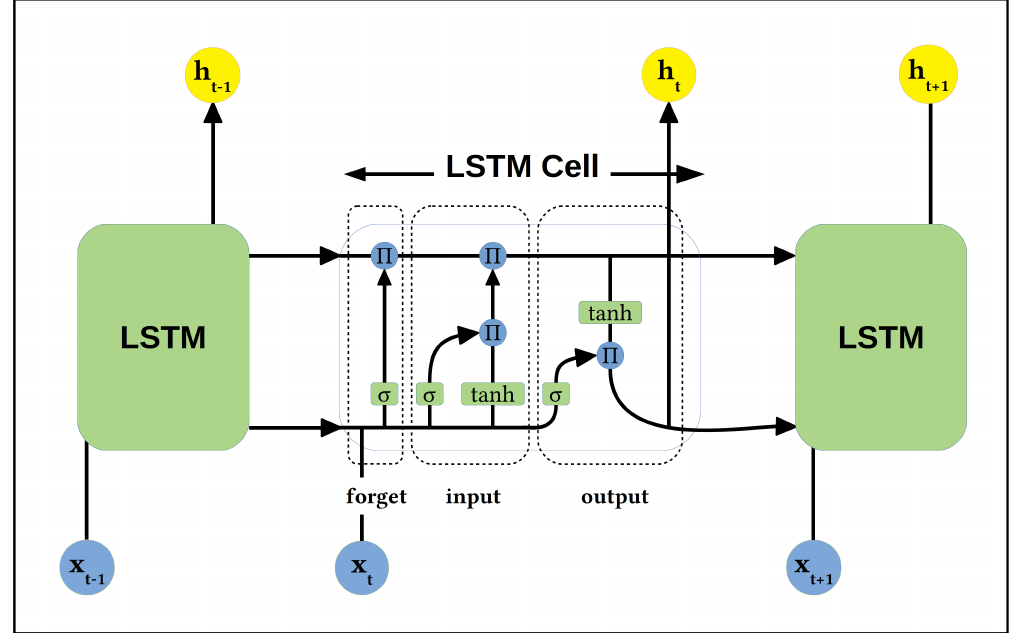
Figure 2. Basic Long-Short Term Memory (LSTM)